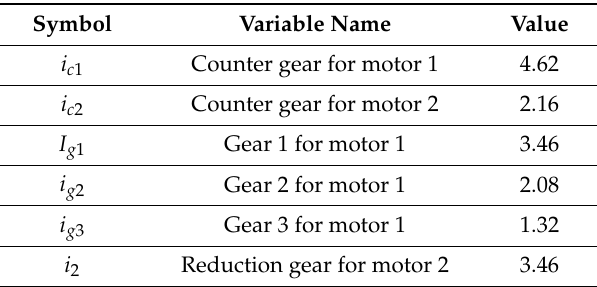
Table 1. Gear Table 1. Gear ratios.